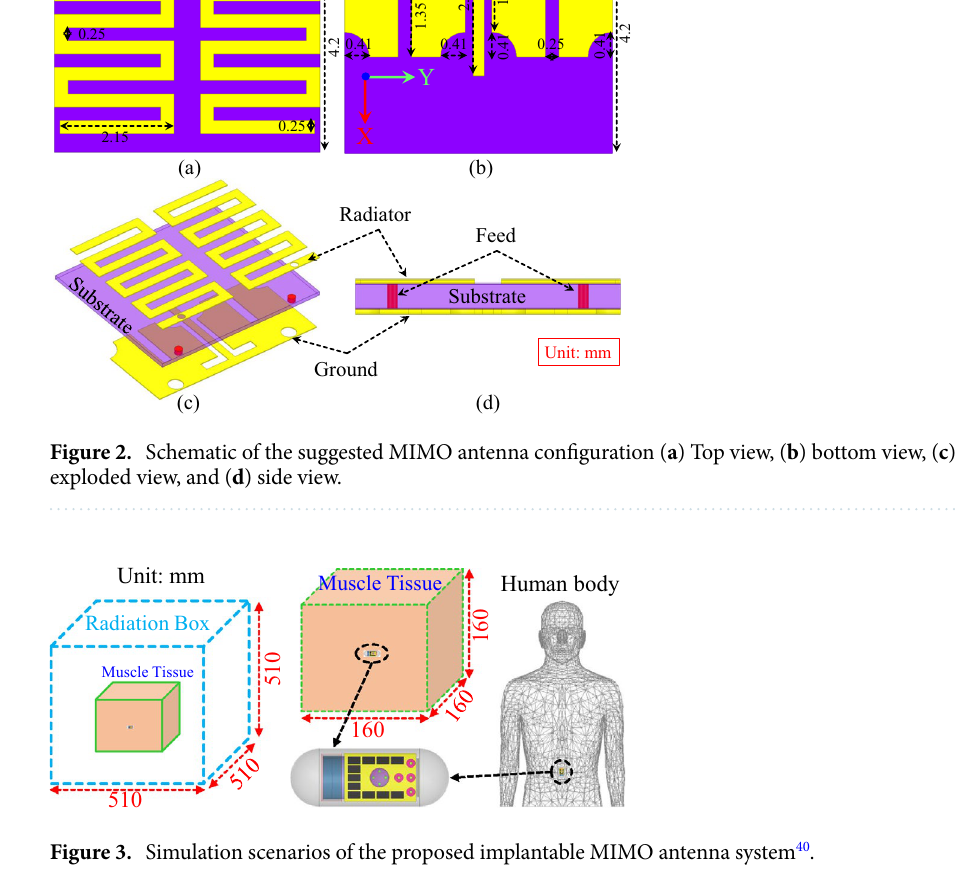
Figure 3. Simulation scenarios of the proposed implantable MIMO antenna system 40